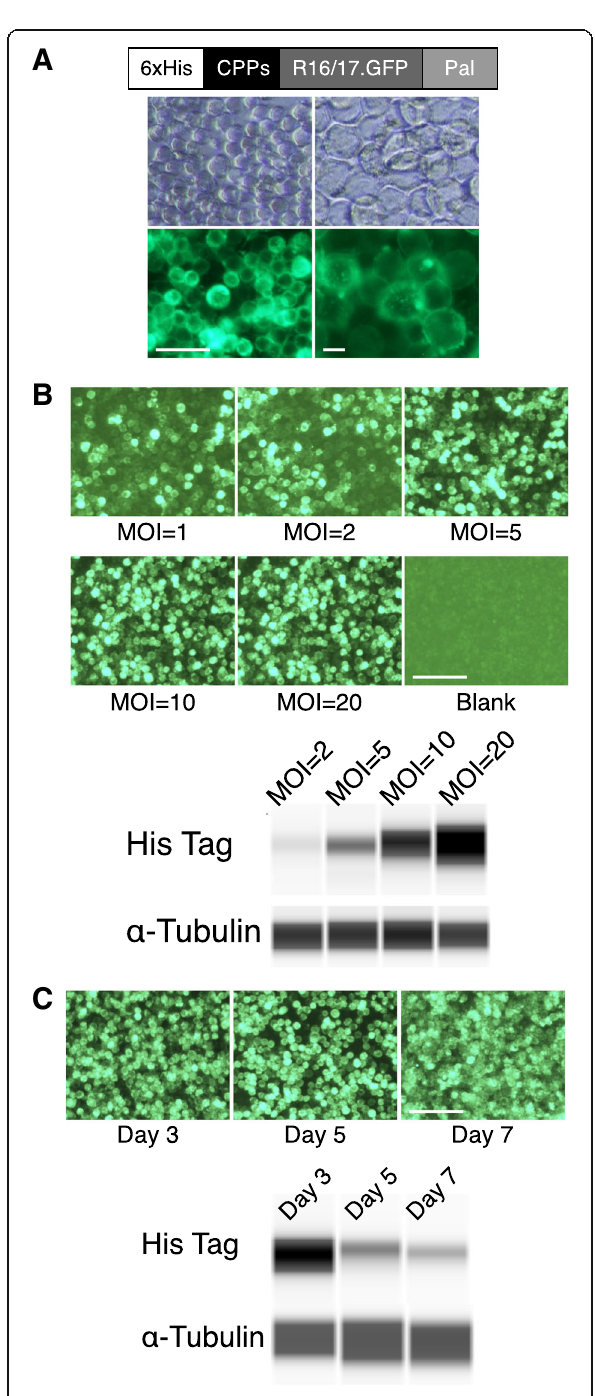
Fig. 1 Dystrophin R16/17.GFP.Pal protein is expressed in insect cells and localized at the cell membrane. a Configuration of recombinant dystrophin R16/17.GFP.Pal protein and R16/17 protein expression in insect cells. Top panel: light microscopy; Bottom panel: fluorescence microscopy for GFP signal; Left panel: 10X; Right panel: 20X. The dystrophin R16/17.GFP.Pal protein was successfully expressed in the baculovirus-insect cell system and localized at the cell membrane. Left scale bar = 50 μ m; Right scale bar = 10 μ m; b Optimal MOI was determined for R16/17 protein production. The GFP signal was observed on day one after baculoviruses infection of High Five insect cells with different MOIs. The expression level from different MOIs was examined by western blot with an anti-His tag antibody, and α -tubulin serves as the loading control. Scale bar=50 μ m; c Optimal harvesting time was determined for R16/17 protein production. High Five cells were infected with baculoviruses (MOI=20). The GFP signal and the expression of R16/17.GFP protein were examined 3, 5 and 7 days after virus infection by fluorescence microscopy and western blot with an anti-His tag antibody, respectively. The level of α -tubulin is used for the loading control. The highest protein expression was found 3 days after virus infection. Scale bar=50 μ m. Western blot was performed with ProteinSimple WES capillary western blot